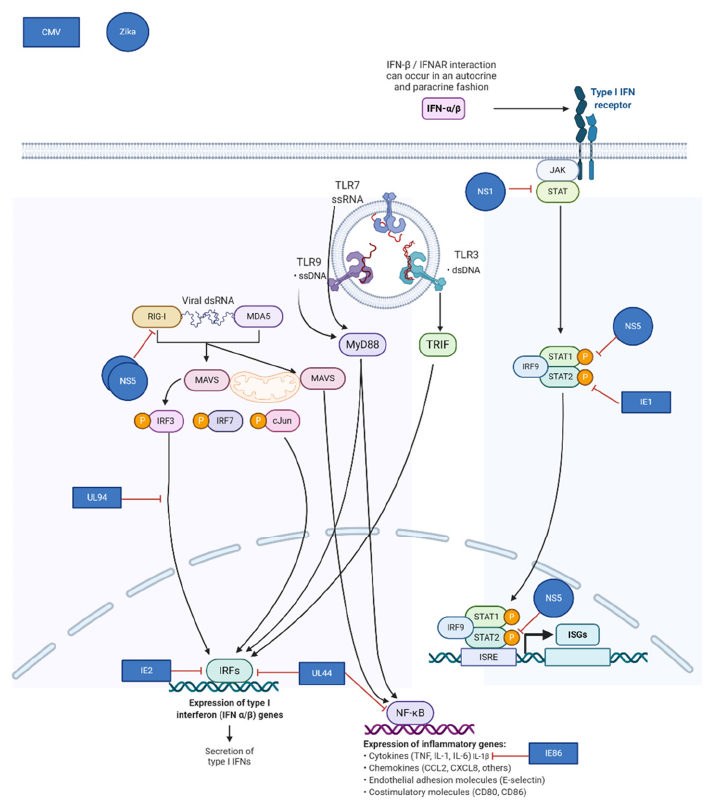
Figure 2. Mechanisms of viral immune evasion in the placenta utilized by cytomegalovirus (CMV) and Zika virus. Adapted from “TLR Signaling Pathway”, by BioRender.com (Accessed on 6 February 2021). Retrieved from https://app.biorender.com/biorender-templates.